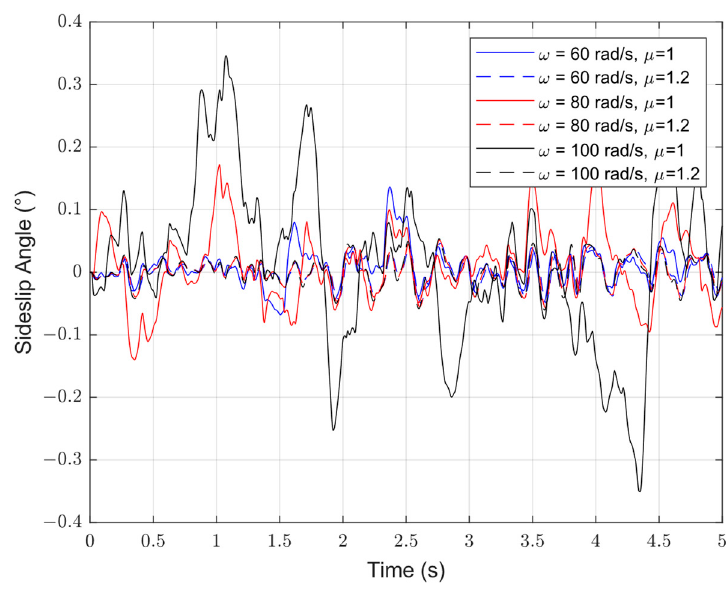
Figure 9. Response of Sideslip Angle with Measurement Noise.